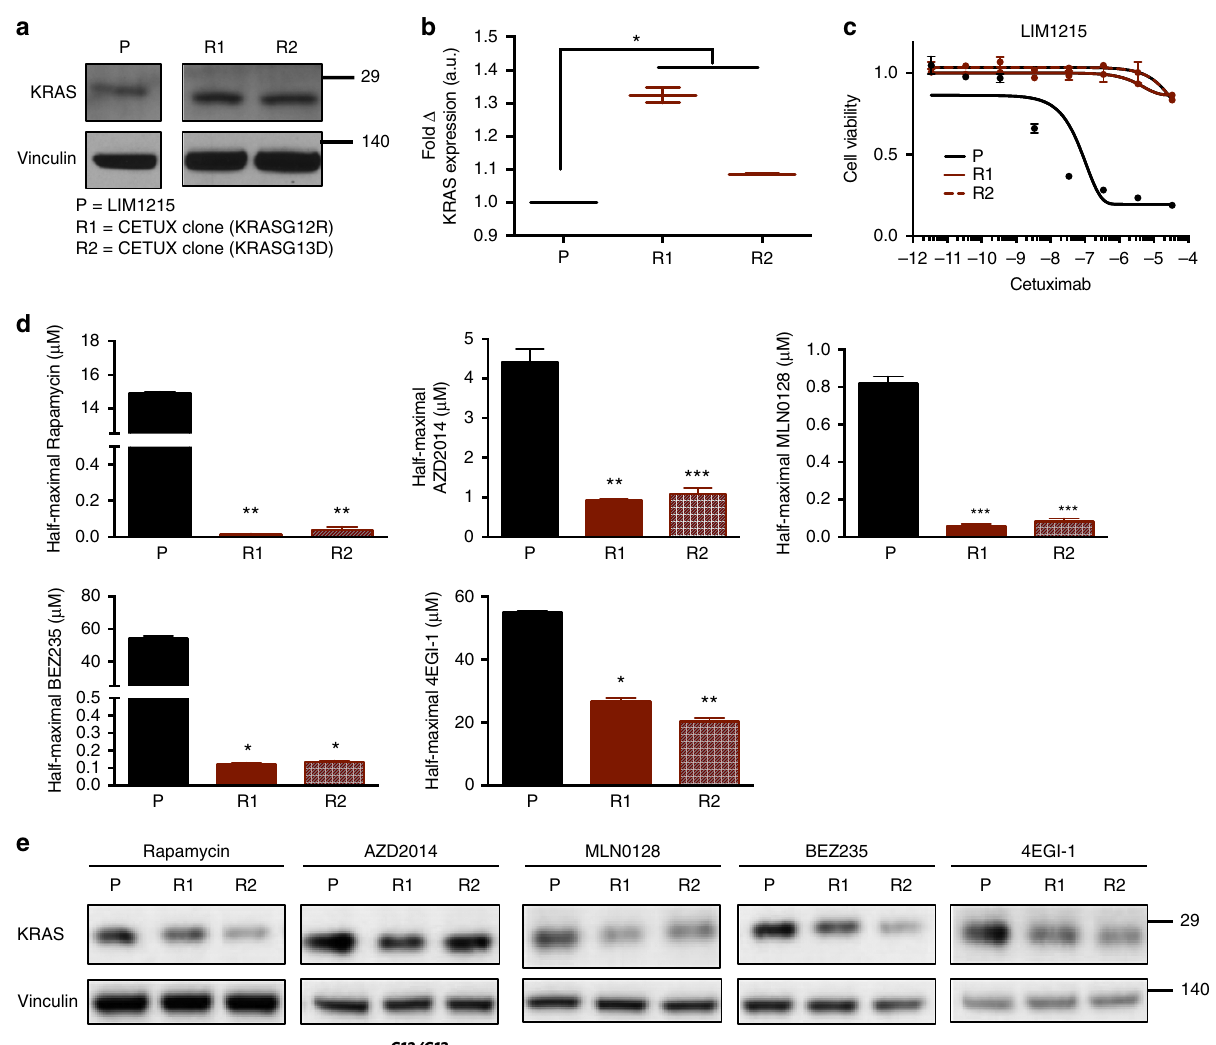
Figure 6 | Translation-dependent state of KRAS G12/G13 -mutant cells enables selective targeting of anti-EGFR resistant colorectal cancer. ( a ) Immunoblot analysis for endogenous KRAS levels in parental (P) and derived KRAS mutant, cetuximab-resistant (R1 and R2) clones. ( b ) Fold change in KRAS protein levels, normalized to loading control, between resistant derivatives (R1 and R2) and parental cells (P). ( c ) Nonlinear regression growth curves depicting cell viability as assessed by Cell Titer Glo (CTG) of parental (P) and matched resistant derivatives (R1 and R2) treated with cetuximab. ( d ) Derived half-maximal growth inhibition values of parental (P) and matched resistant derivatives (R1 and R2) treated with Rapamycin, AZD2014, MLN0128, BEZ235 and 4EGI-1. ( e ) Immunoblot analysis of KRAS protein levels in parental (P) and resistant derivatives (R1 and R2) following 4h treatment with the corresponding inhibitors in d . Images are cropped for clarity from the same exposure of the same membrane. Error bars show data ± s.e.m. ( n ¼ 3 technical replicates per condition). * P r 0.05; ** P r 0.01; *** P r 0.001. P values were calculated with unpaired, two-tailed Student’s t